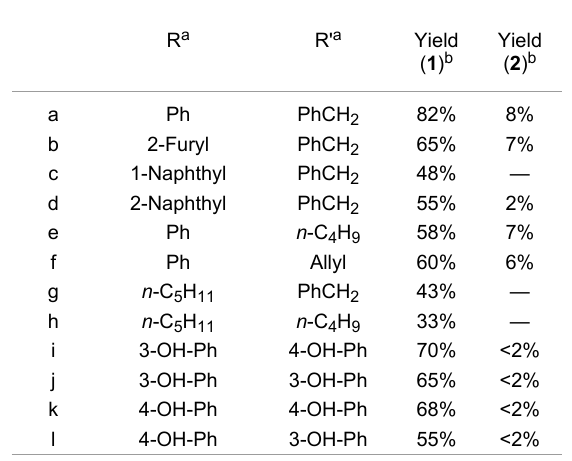
Table 1: Results of the reductive amination with zinc in aqueous base